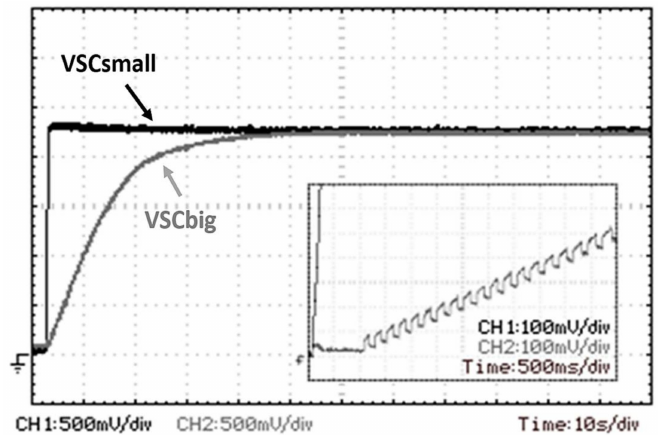
Figure 9. Oscilloscope view of SCsmall (CH1) and SCbig (CH2) voltage signals during charging and startup (inset), following the predefined charging priority feature. The SCbig supercapacitor is connected to the input only when SCsmall is fully charged at 2.3